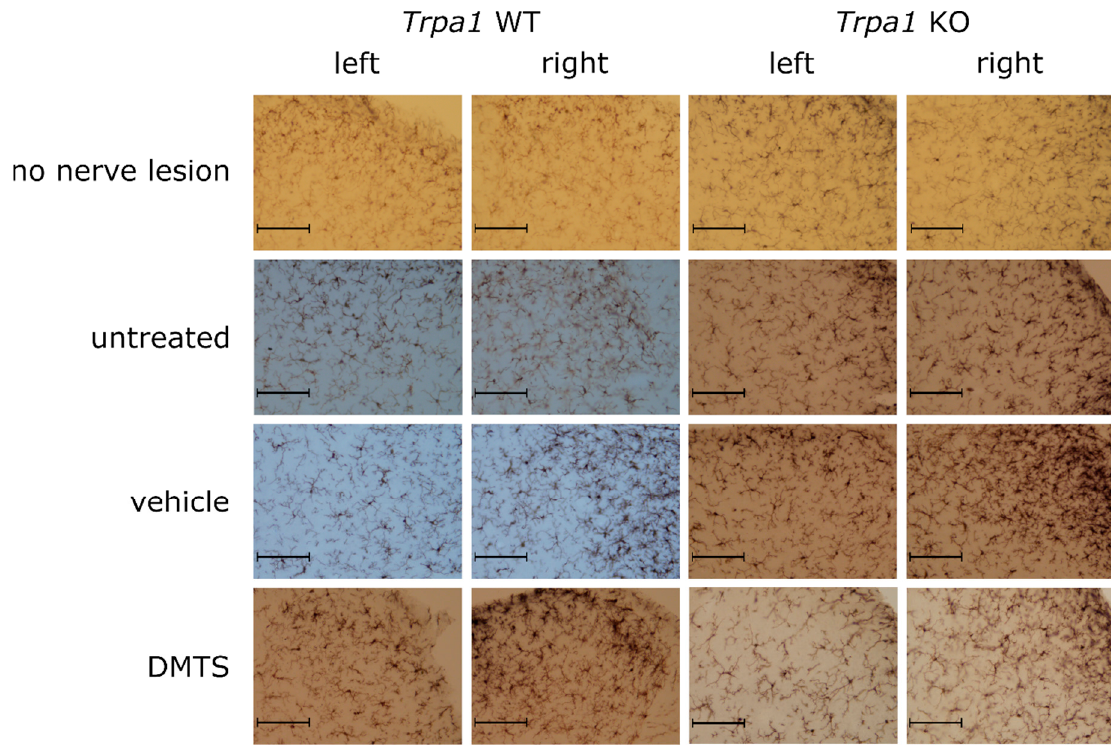
Figure 7. Representative micrographs used for the detection of the activation index of IBA1-positive cells in the spinal cord dorsal horn. Immunohistochemistry was visualized with 3,3 ′ -diaminobenzidine. Images were taken with a 20× objective. Size bars equal to 100 µm.